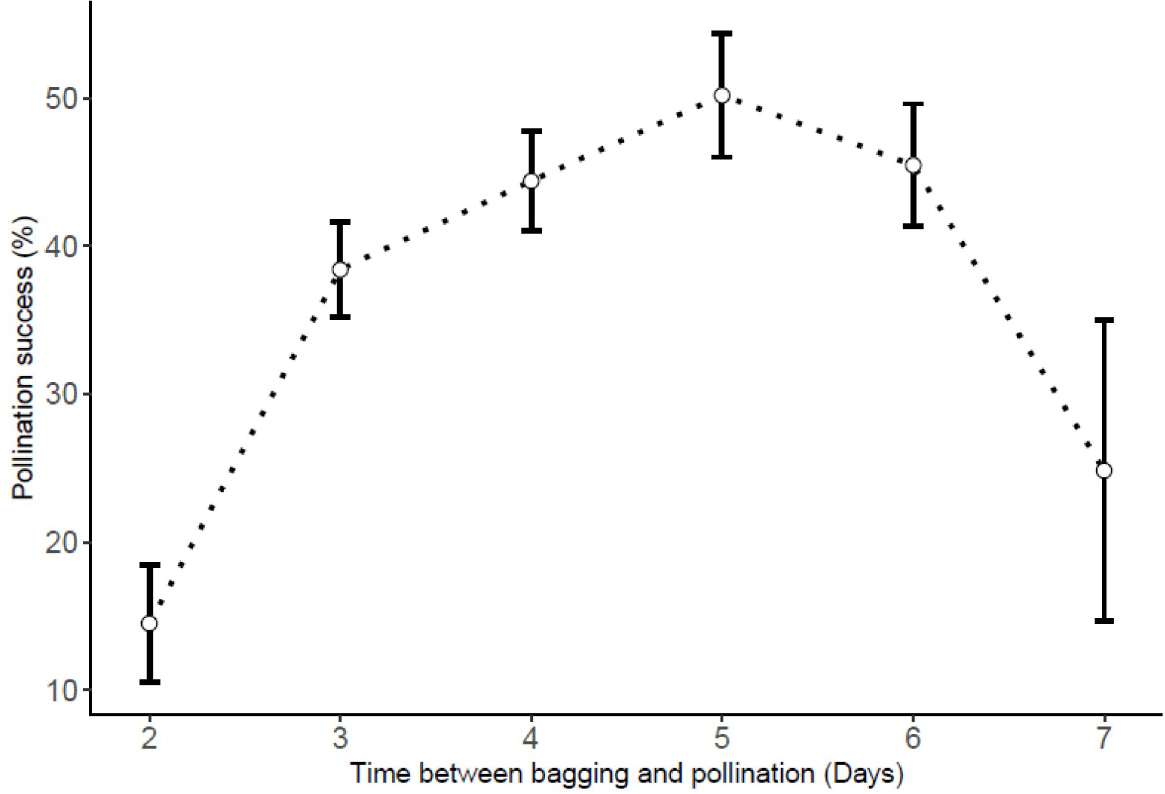
Fig 6. Influence of the time interval between flower bagging and crossing on pollination success rates.